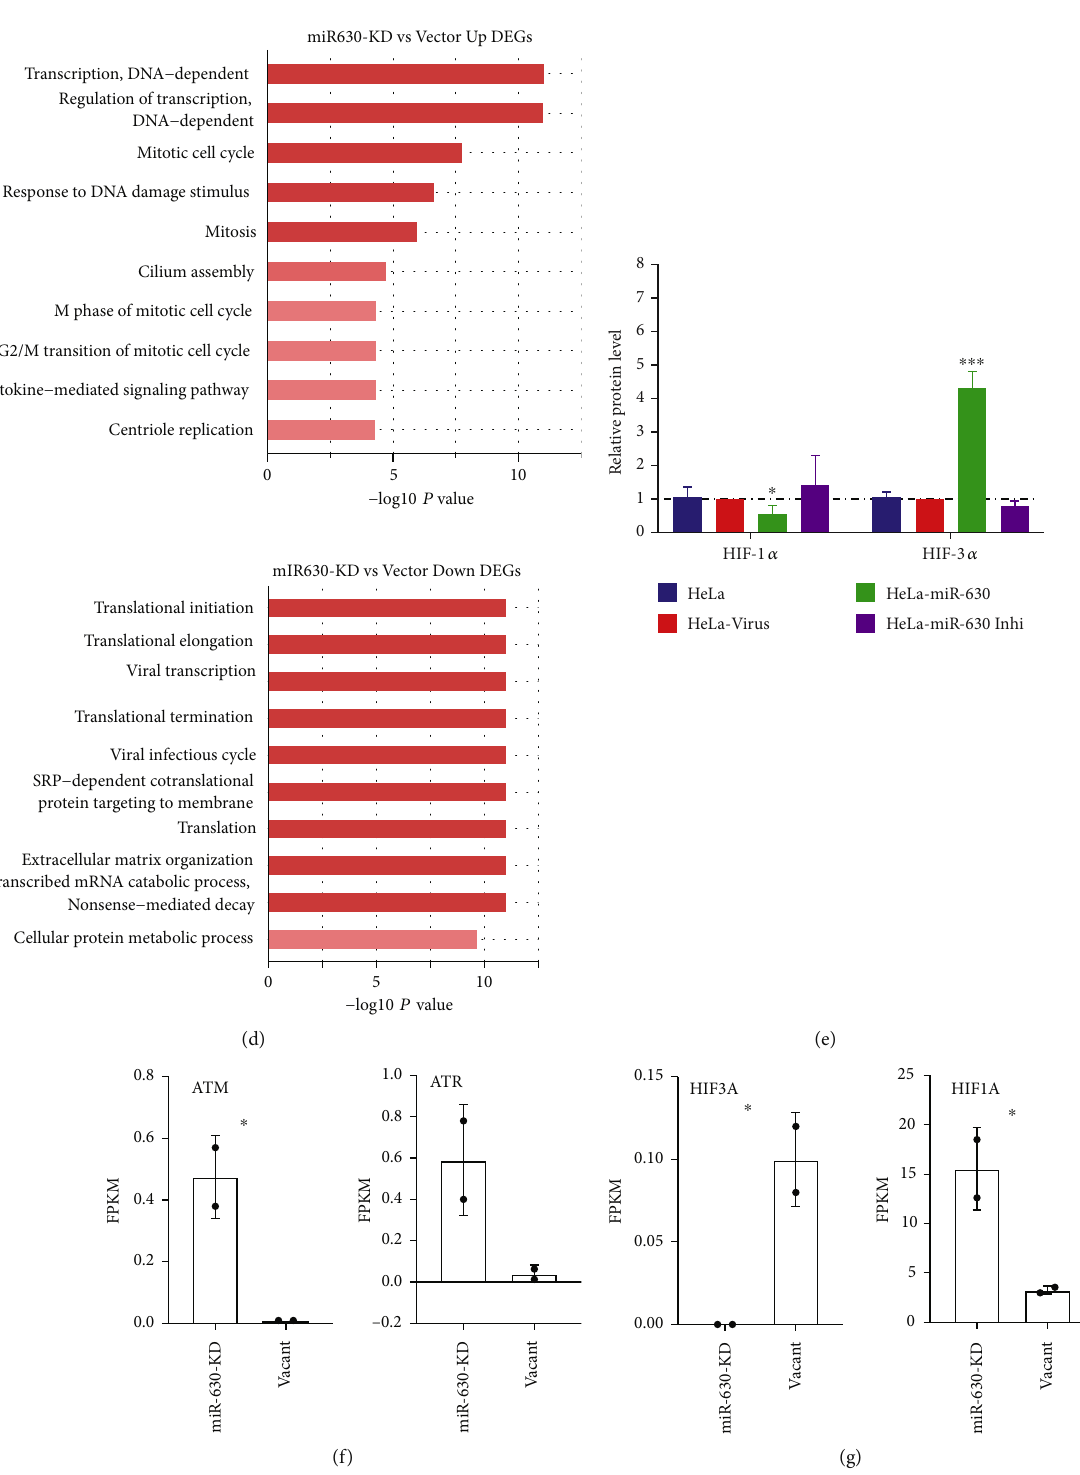
Figure 4: RNA-seq revealed the functions of miR-630 targets in HeLa cells. (a) Read distribution plot showed the signi fi cant HIF3A binding density in the promoter region of miR-630 host gene. Red frame represented the HIF3A binding peak. (b) Bar plot showed the ChIP-qPCR results of the HIF-3a binding density in the promoter region of miR-630 host gene. (c) Western blot showed the expression changes of HIF1A and HIF3A upon miR-630 overexpression and knockdown. (d) Bar plot showed the quanti fi ed levels of WB results shown in (c). Three biological replicates were included in this panel. (e) Bar plot showed the enriched GO BP terms for upregulated genes (left) and downregulated genes (right) by miR-630 inhibition. (f) Bar plot showed the increased expression levels of ATM and ATR by miR-630 inhibition. (g) Bar plot showed the increased expression level of HIF1A and the decreased expression level of HIF3A by miR-630